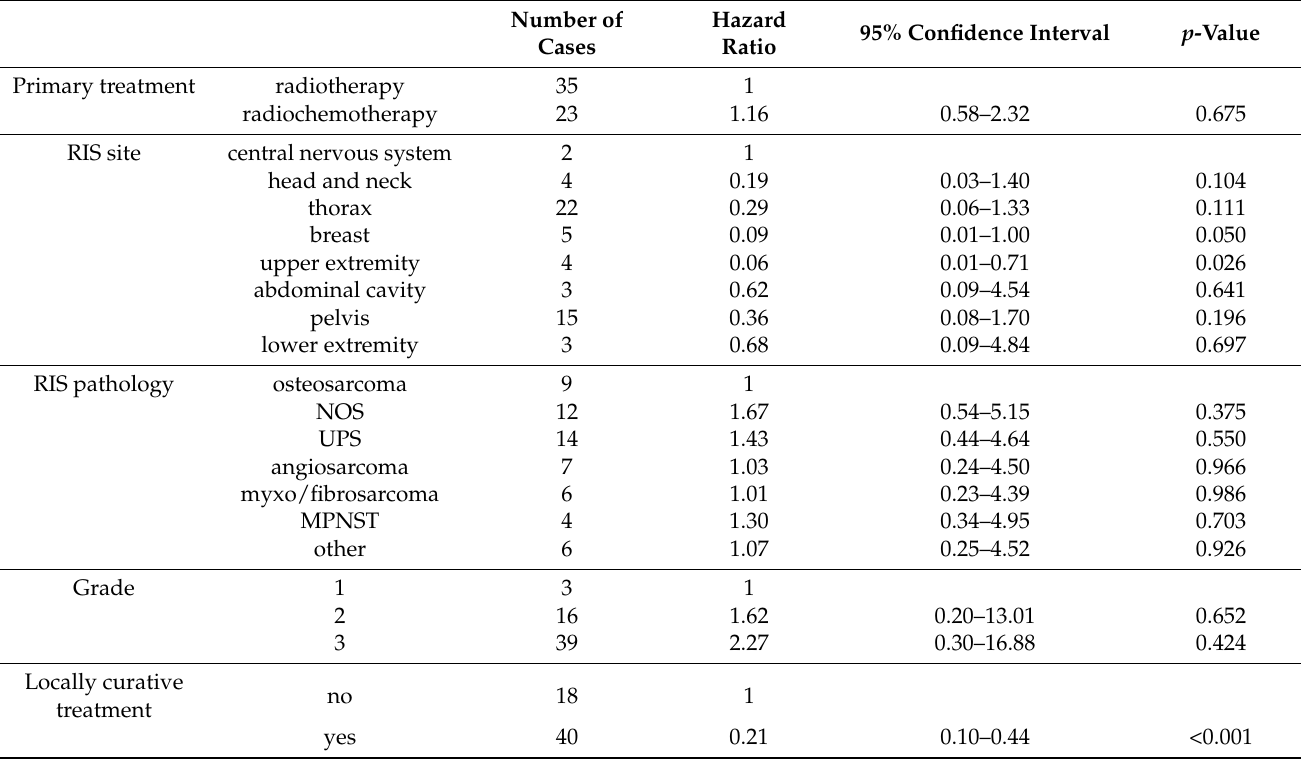
Table 3. Hazard ratios for death with 95% confidence intervals and p -values calculated from a univariate Cox proportional hazards model for all enrolled patients.